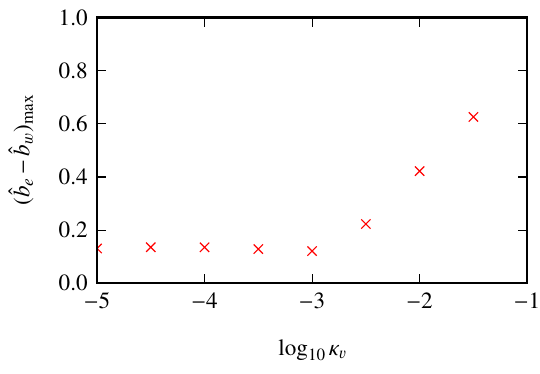
Fig. 8. Dependence on ˆ κ v of the maximum east-west buoyancy difference ( ˆ b e − ˆ b w ) max